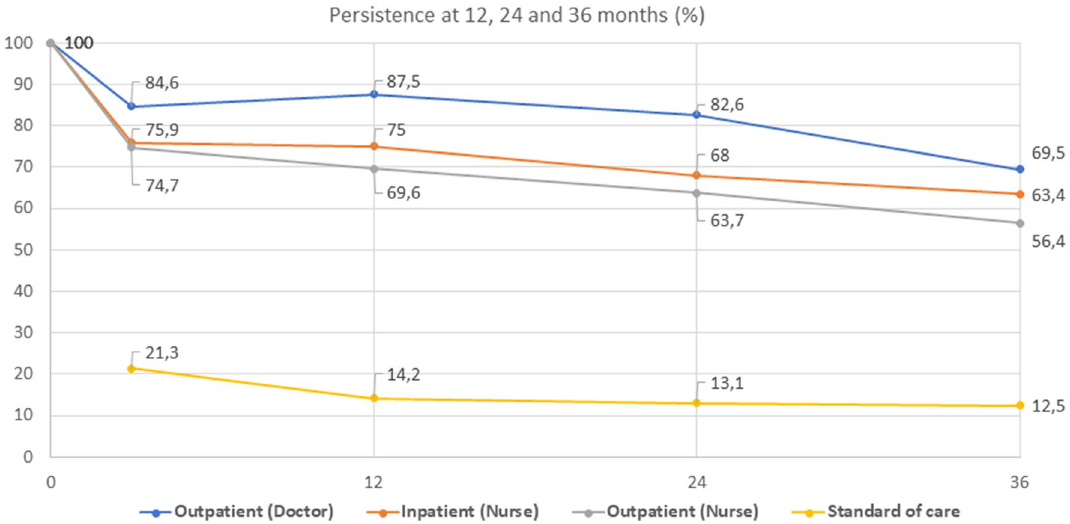
Figure 3. Persistence of treatment with antiosteoporosis medication over a 3-year follow-up in patients and controls. 100% of patients from FLS were recommended antiosteoporotic treatment. Edited with Microsoft 365 A3 for